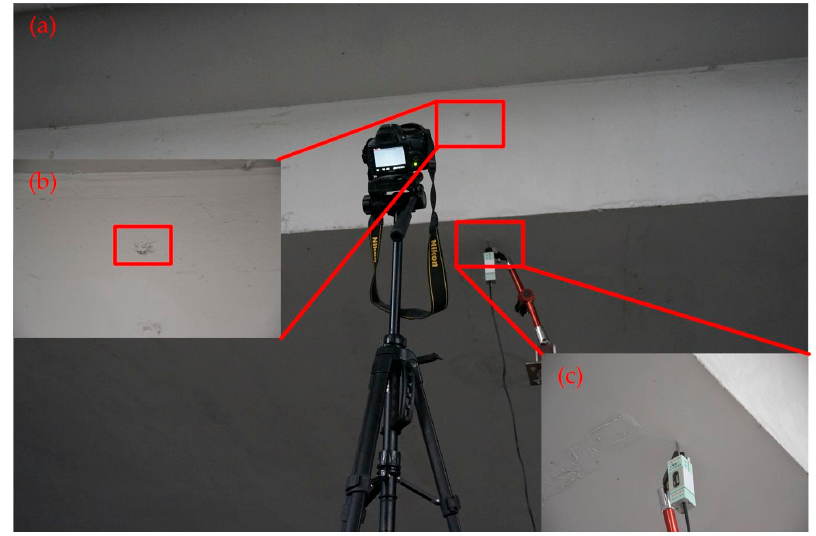
Figure 18. Field test: ( a ) experiment environment; ( b ) natural target; ( c ) displacement by the STDS sensor.